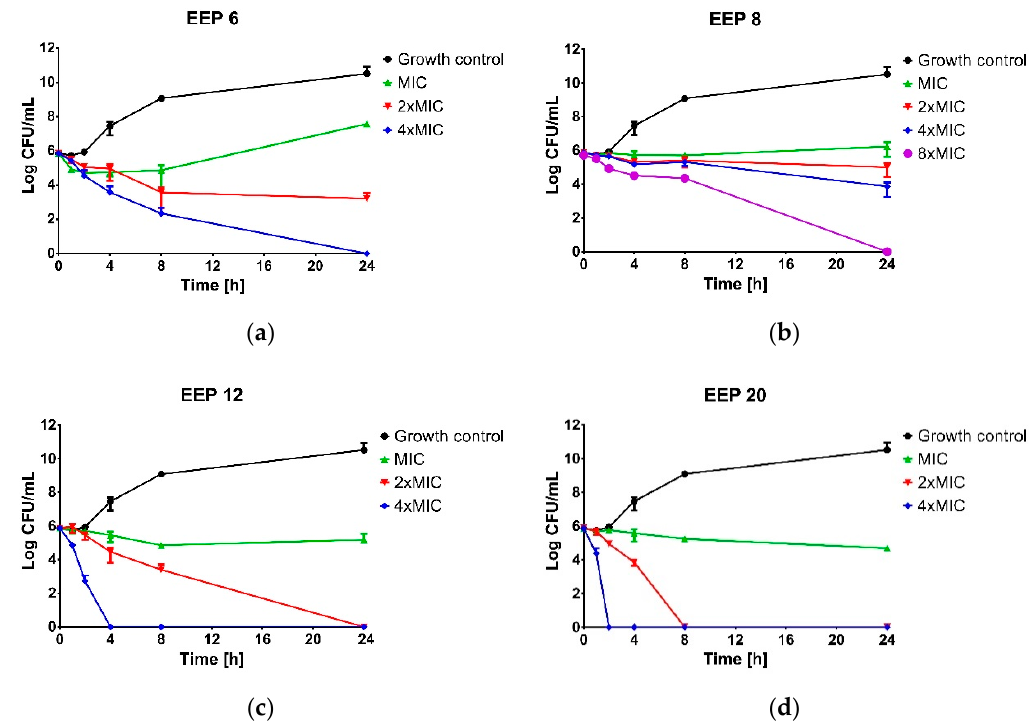
Figure 1. Kill-time assay for selected ethanolic extracts of propolis (EEPs) tested against S. aureus ATCC 25923 at or above the MIC. The growth control contained no extracts. ( A ) EEP 6, ( B ) EEP 8, ( C ) EEP 12, ( D ) EEP 20. The results are presented as means ± SD ( n = 3). Data without error bars indicates that the SD is too small to be observed on the graph.